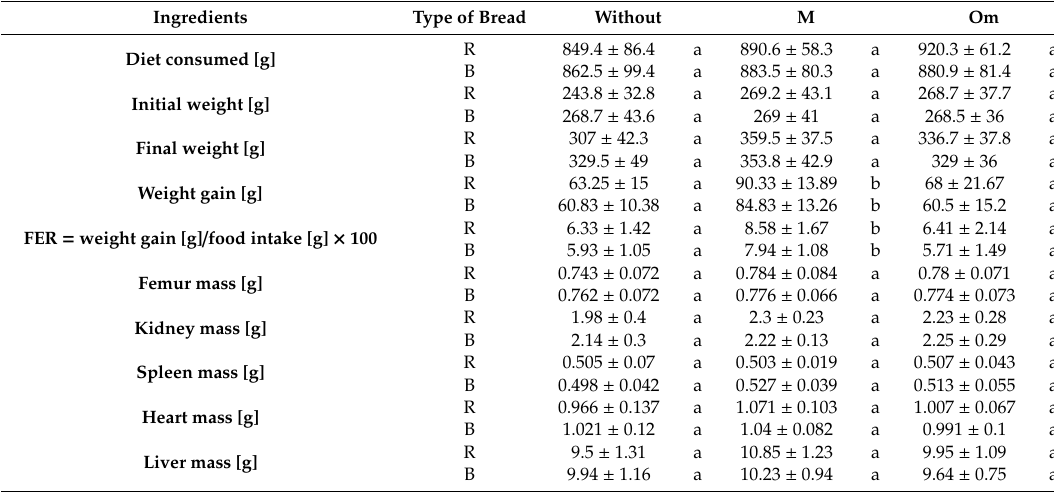
Table 1. General nutritional parameters of